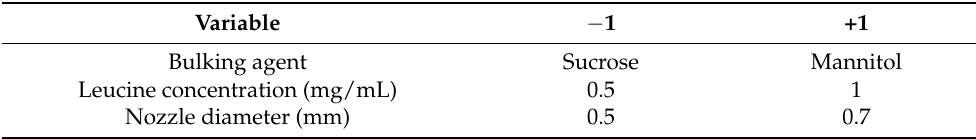
Table 1. Coding of variables for the 2 3 full factorial